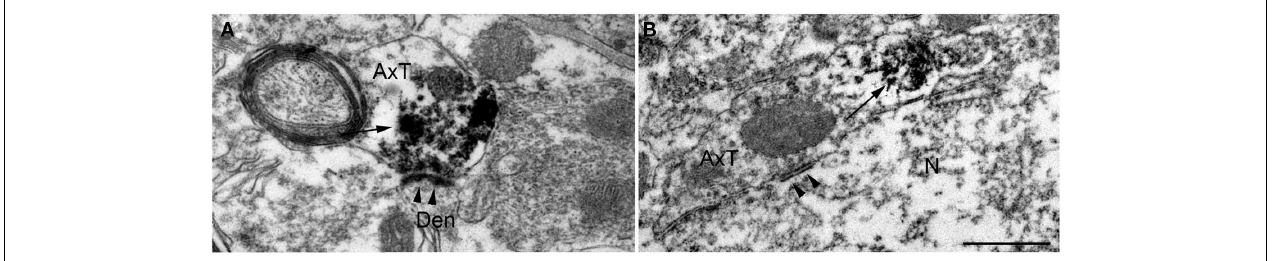
FIGURE 4 | Pre-embedding electron microscopy studies show that SV2B immunoreactivity [arrows in (A,B)] is present in axon terminals forming both asymmetric [arrowheads in (A); layerV] and symmetric [arrowheads in (B); layerV] synaptic contacts. AxT, axon terminal; Den, dendrite; N, pyramidal neuron. Scale bar: 500nm (A,B) .